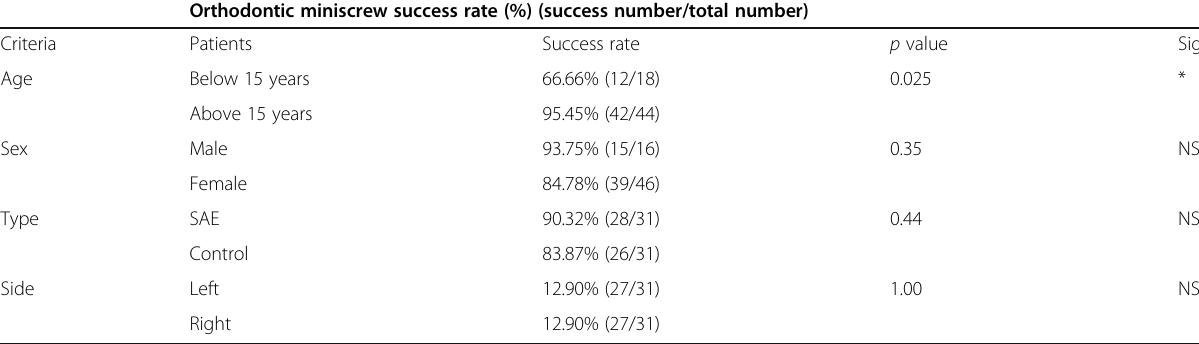
Table 1 The success rate (%) of orthodontic miniscrews Orthodontic miniscrew success rate (%) (success number/total